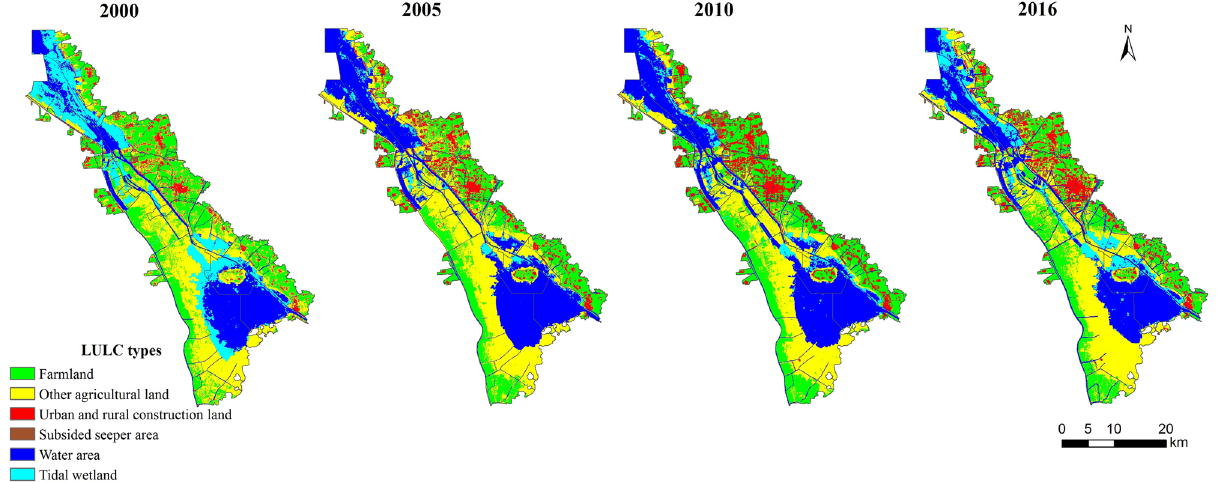
Figure 2. The LULC types maps of 2000, 2005, 2010 and 2016. Maps were generated using ArcGIS 10.1 for Desktop (http:// www. esri. com/ softw are/ arcgis/ arcgis- for- deskt op).